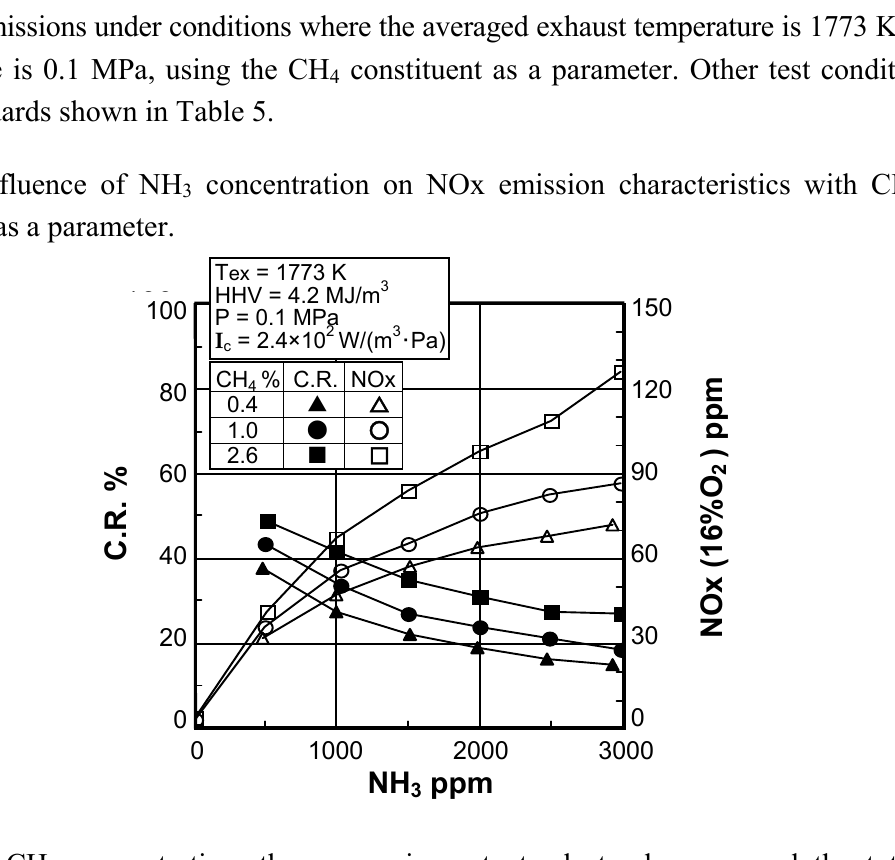
concentration on NOx emission characteristics with CH 3